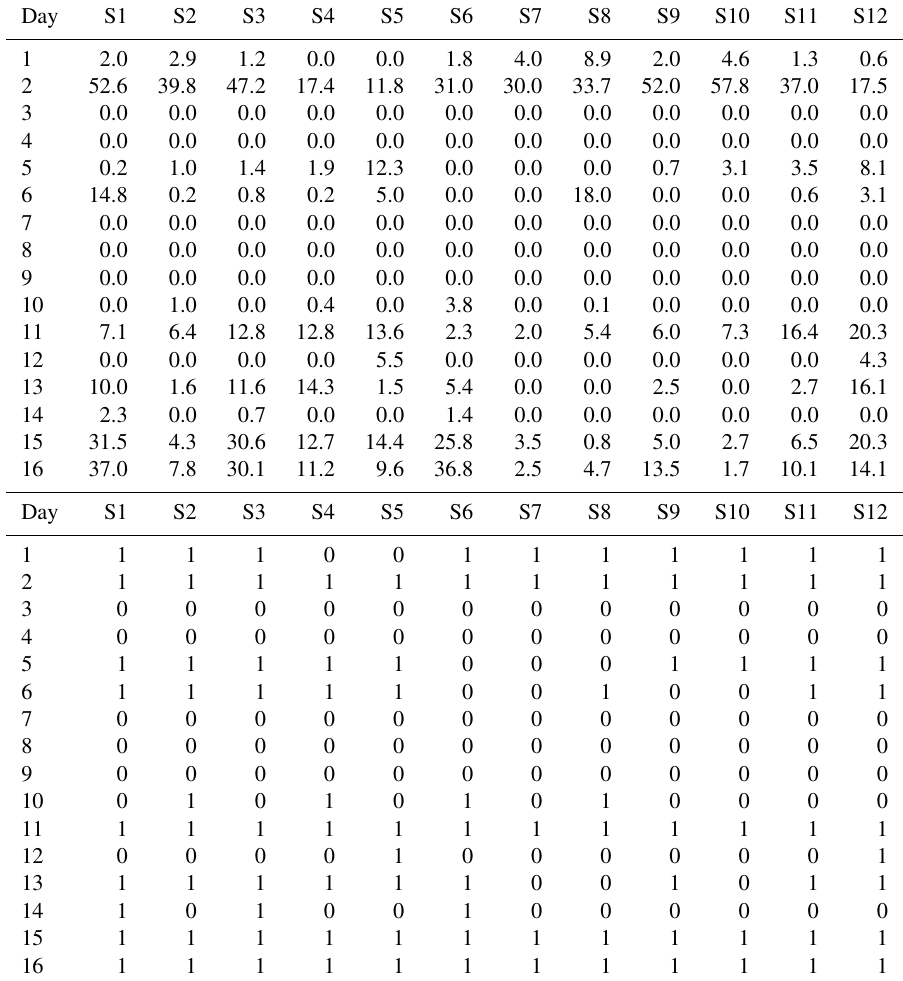
Table Appendix A1. Example dataset of daily rainfall with 12 weather stations and 16 days for measured rainfall (mm) in the upper part of this table and its corresponding occurrences in the bottom part of this